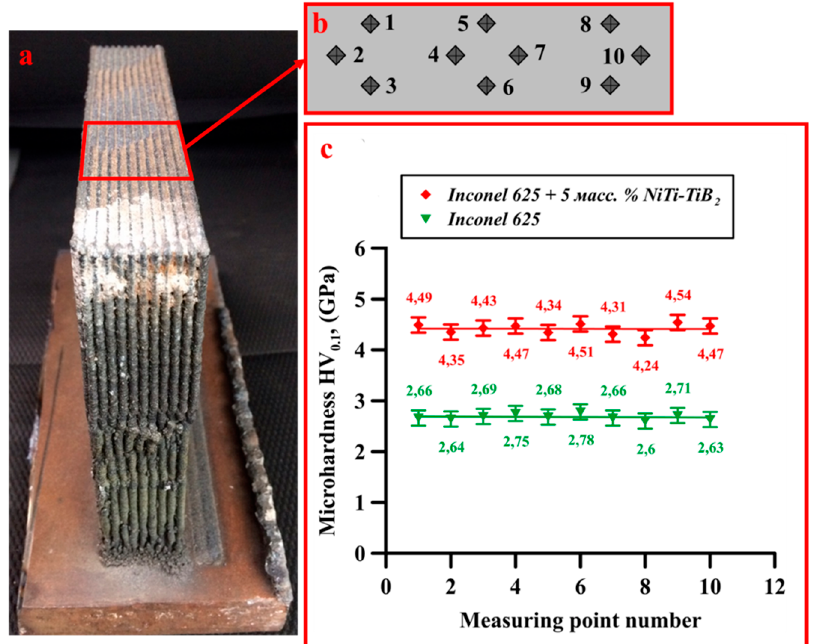
Figure 4. (a) Appearance of the materials obtained by direct laser deposition from a powder mixture of 95 wt% Inconel 625 + 5 wt% NiTi–TiB 2 ; ( b ) a schematic of the distribution of indenter marks on the sample; ( c ) a diagram of the distribution of hardness values in the sample.